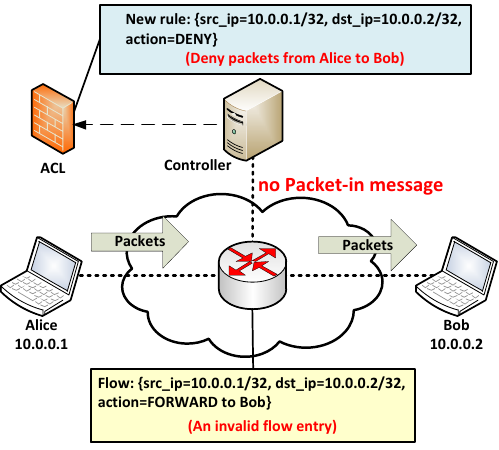
Figure 1. Network security violation in a reactive way